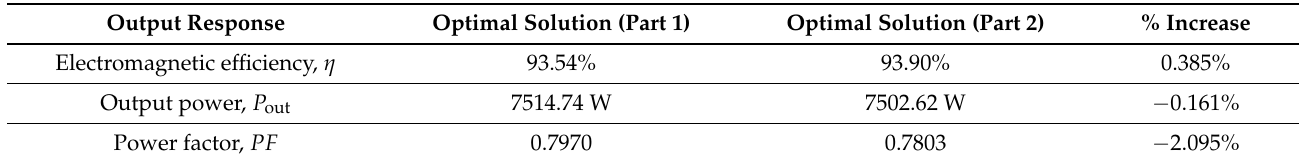
Table 12. Surrogate optimal solution compared with the improved optimal solution (part 1—surrogate optimization vs. part 2—pattern search) of the proposed optimization routine–multivariate optimization